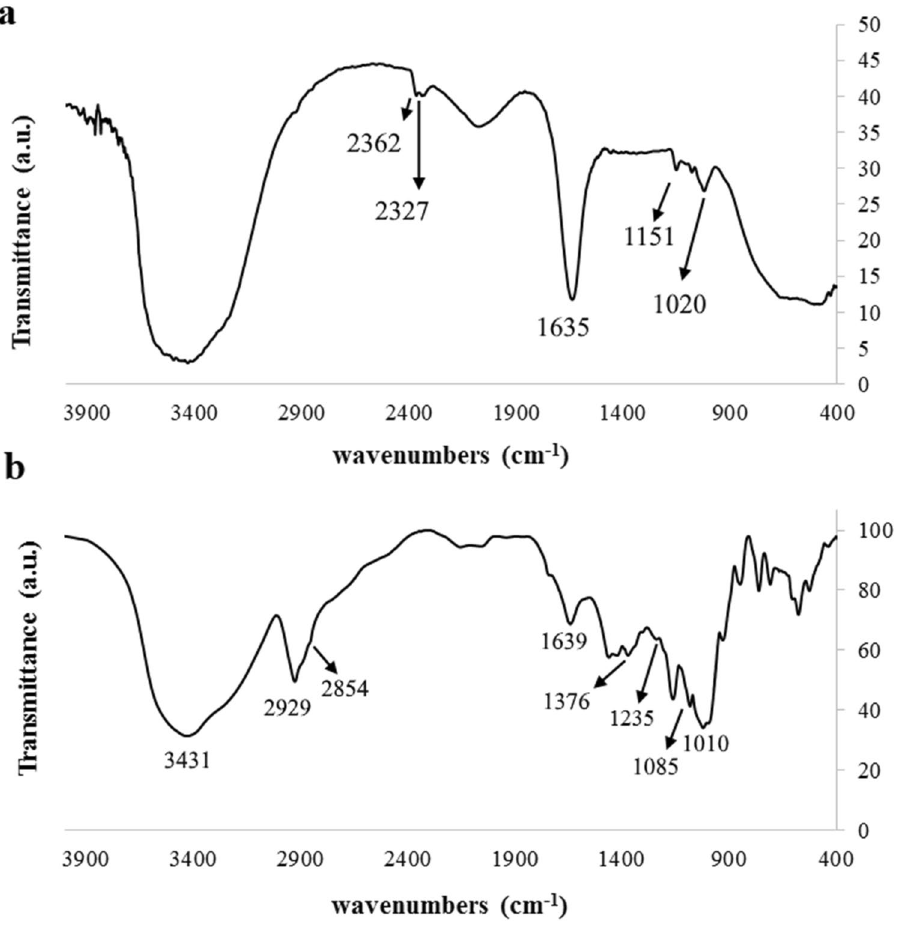
Figure 2. ( a ) The FTIR spectrum of the ( a ) starting starch and ( b ) the synthesized